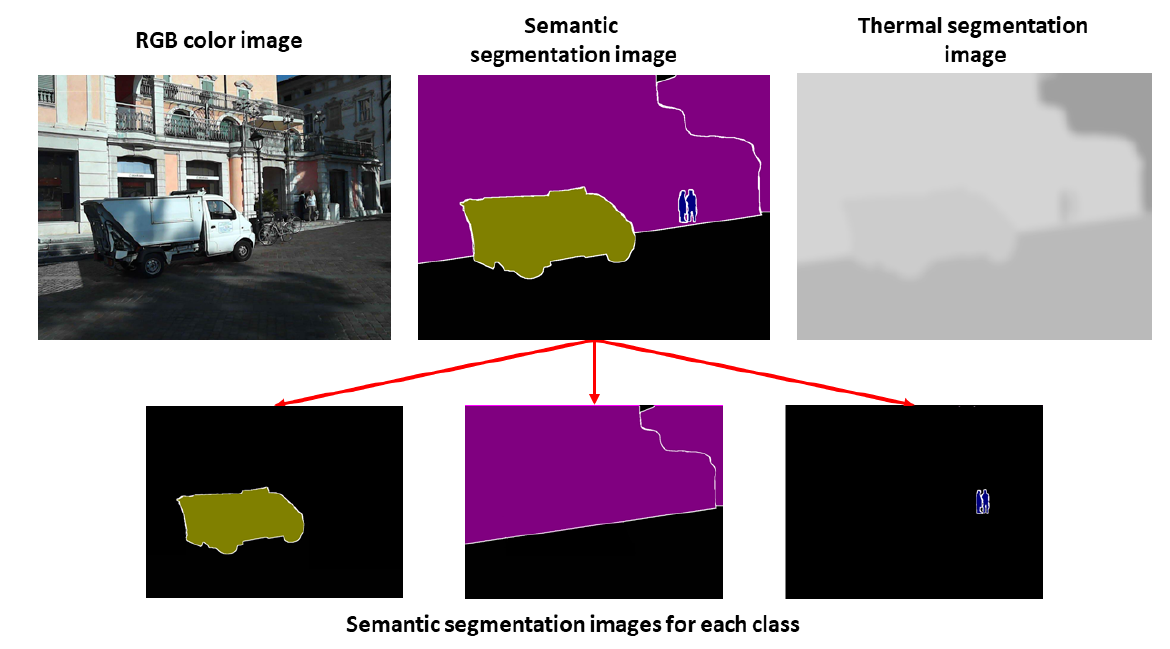
Figure 4. Example of input image tensor for the second